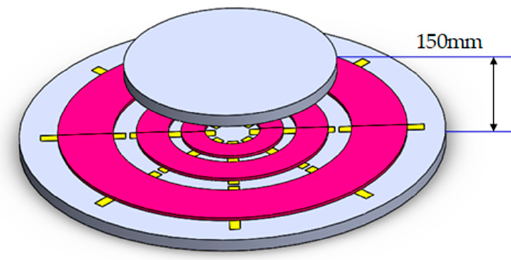
Figure 14. Five-coil system modeling.